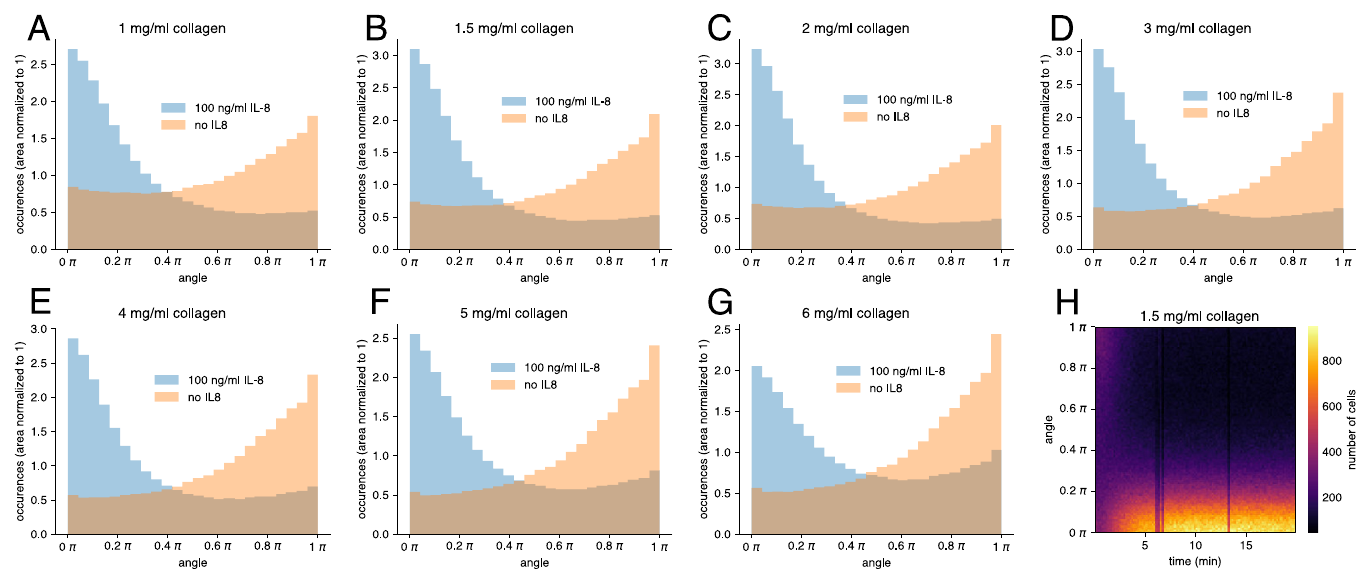
Fig 6. Distribution of migration angles throughout the experiments shown in Fig 5A. (A) - (G) : Cumulative histograms showing the distribution of migration angles of cells migrating in collagen environments of different concentrations along an IL-8 gradient (blue) and without stimulation (red), experiment time 20 min (H) : Two- dimensional histogram of migration angles against experiment time for a collagen concentration of 1.5 mg/ml within a 100 ng/ml IL-8 gradient. The graph shows that directed movement of the cells sets in over a time period of � 5 min. Each graph in every figure displays the weighted average of three independent experiments.